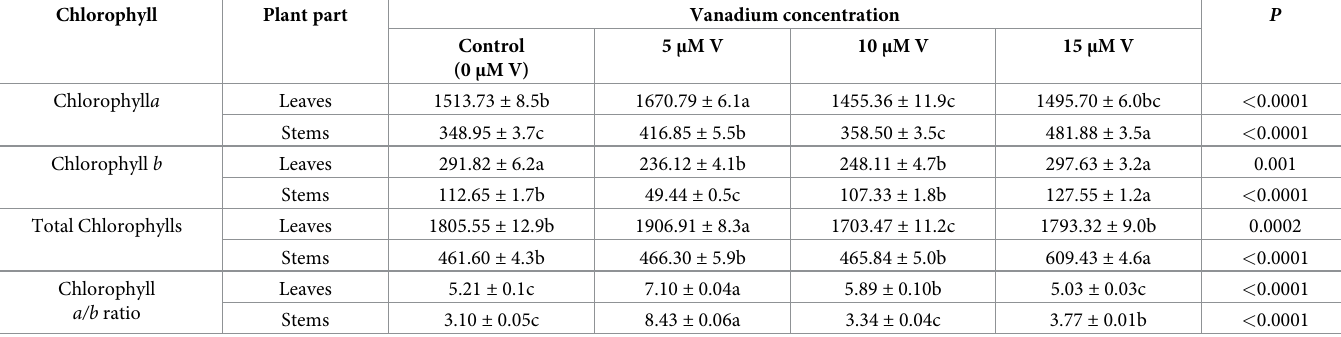
Values are means ± standard error (SE) from at least five individual plants. Different letters in each row indicate significant differences among treatments for each molecule and plant part analyzed (Duncan, α =